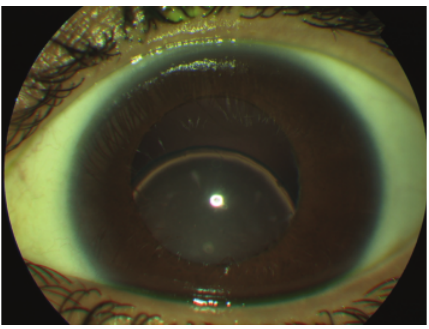
Figure 2: Inferiorly subluxated lens.